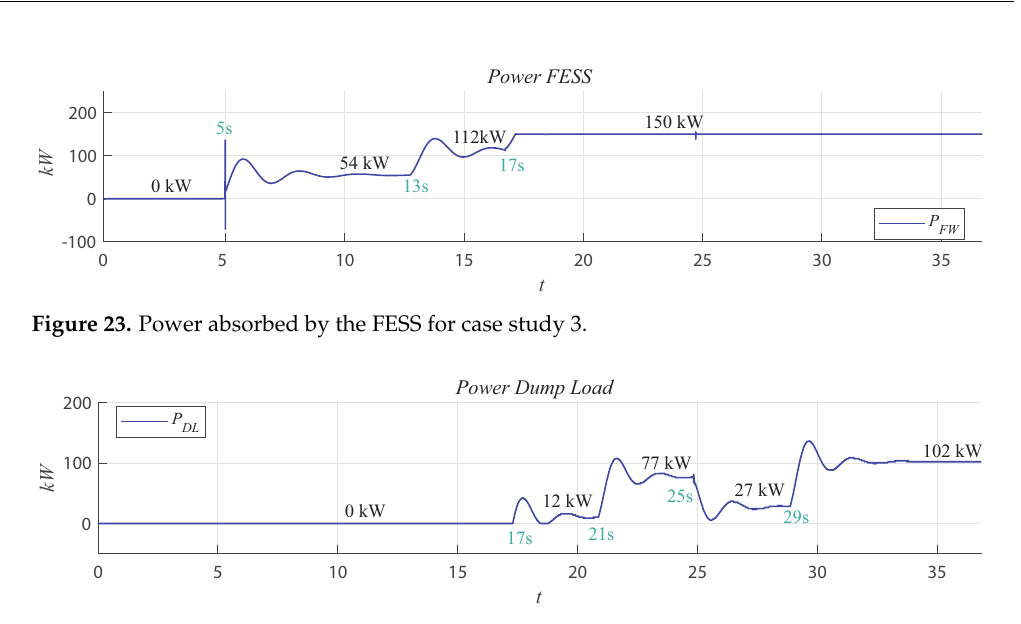
Figure 24. Power in the DL for case study 3.